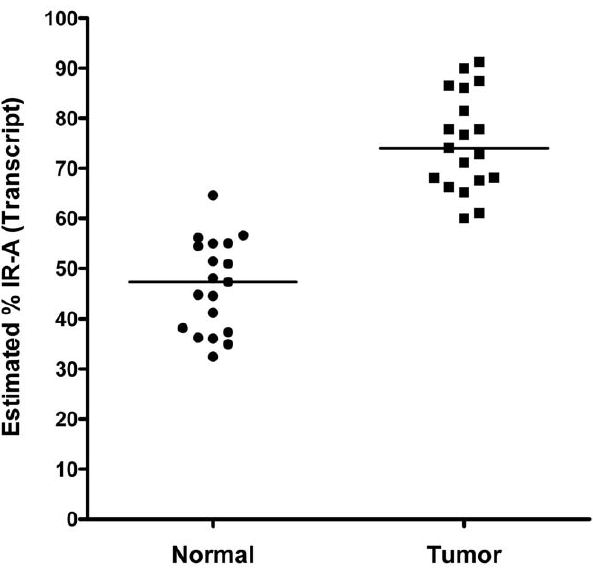
Figure 3. The proportion of IR-A expression in matched normal breast and breast cancer specimens. Within sample proportion of insulin receptor isoform-A (IR-A) relative to total insulin receptor composition (ie, IR-A + IR-B) as determined by 2 (- D Ct) calculation. A paired sample t-test analysis indicated that a significant difference exists for calculated IR-A proportion between matched normal and tumor samples ( P , 0.001). Black bars represent the median IR-A proportion (%) within the normal (46.60 6 4.74, mean % 6 95% CI) and